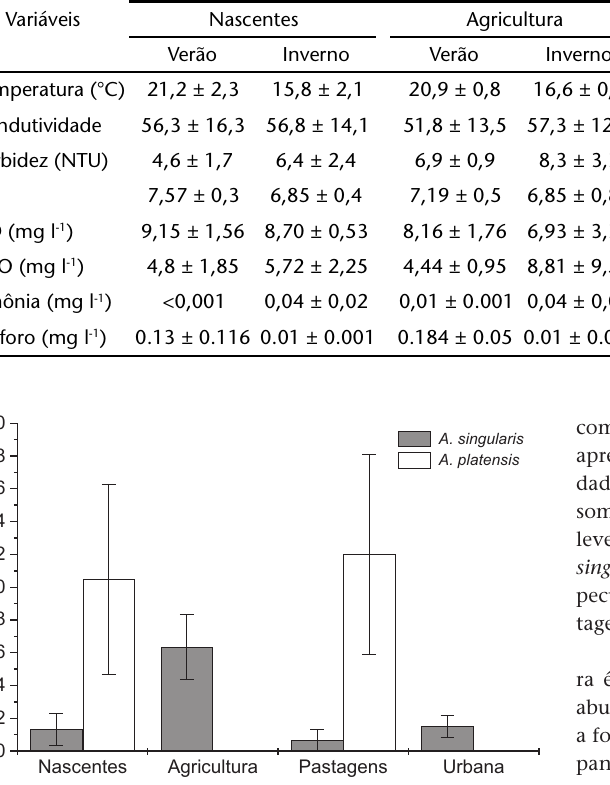
Figura 4. Densidade (ind m - ²) de A. platensis e A. singularis em função do uso da terra na bacia hidrográfica do Rio Jacutinga, Rio Grande do